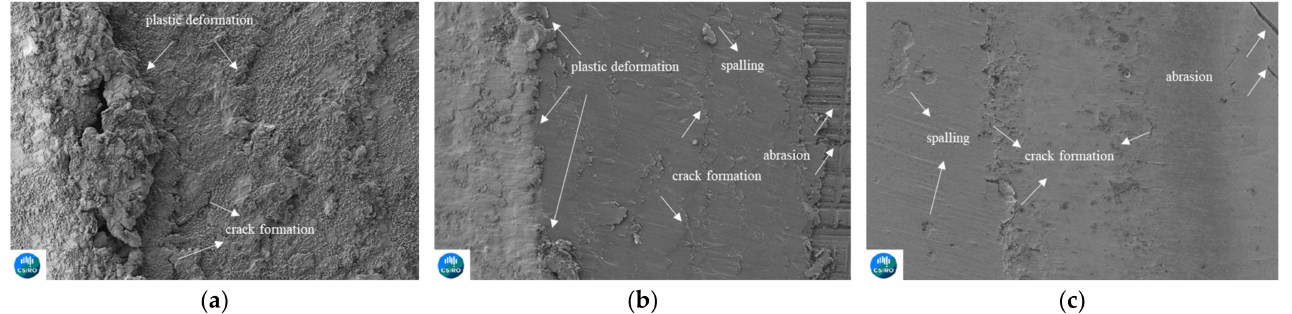
Figure 10. SEM images of ( a ) non-clad light rail, ( b ) SS412, and ( c ) Stellite 6 cladding depositions after roller-on-disc